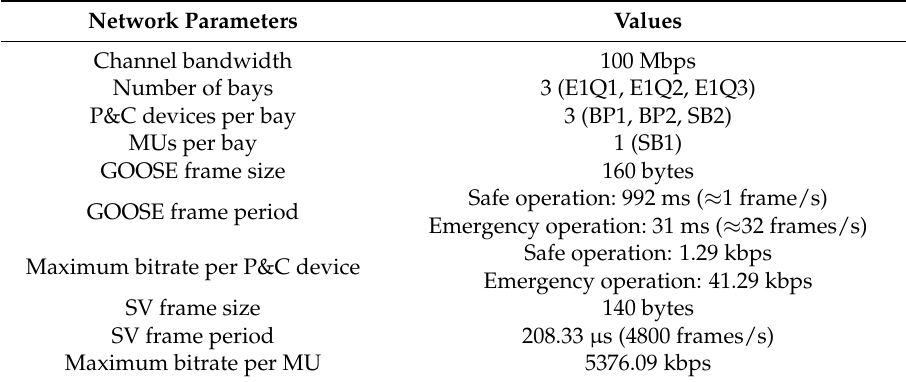
Table 2. Network characterization for the T1-1 case study.